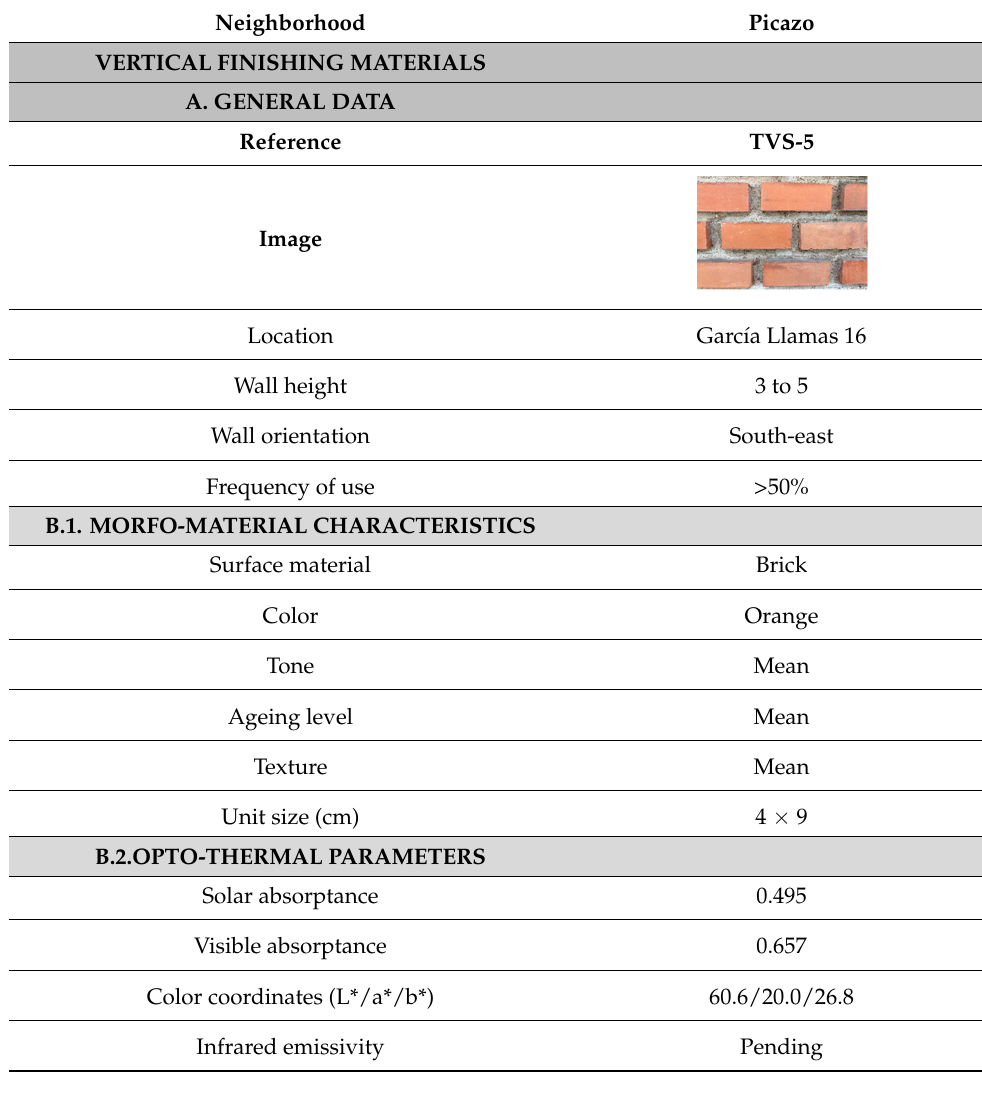
Table 1. Representative information sheet obtained from the experimental campaigns. Table 1. Cont.